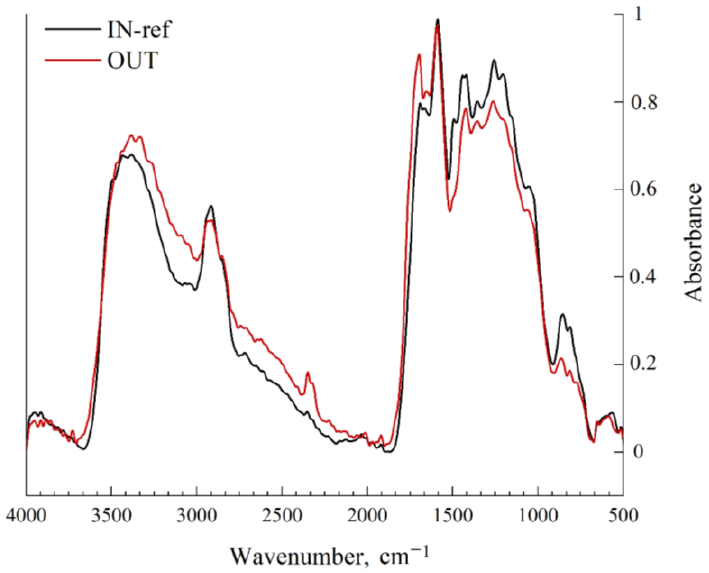
Figure 5. Photoacoustic Fourier infrared (PAS-FTIR) spectra of samples charred at 450 °C stored inside (IN-ref) and attached to the wall (OUT).